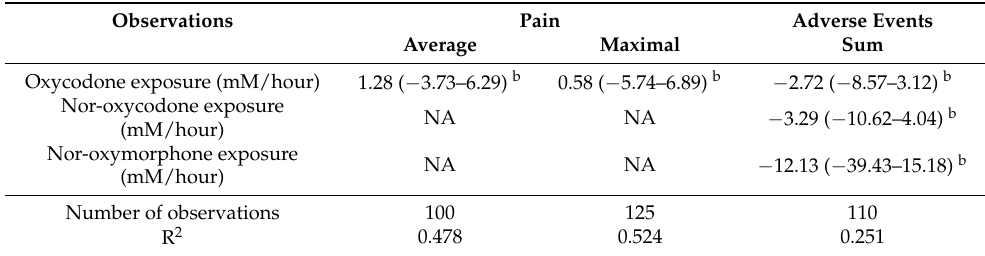
Table 3. Results of the mixed-effects linear regression regarding exposure–response associations a . Observations Pain Adverse Events Average